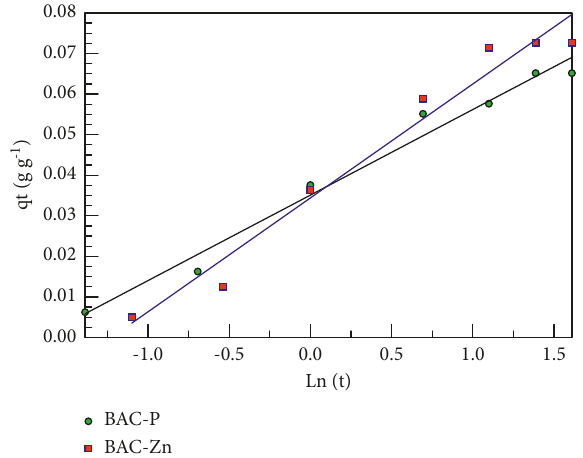
Figure 18: Elovich kinetics for adsorption of 1 g L − 1 Cu(II) ions onto the BAC-P and BAC-Zn adsorbents.